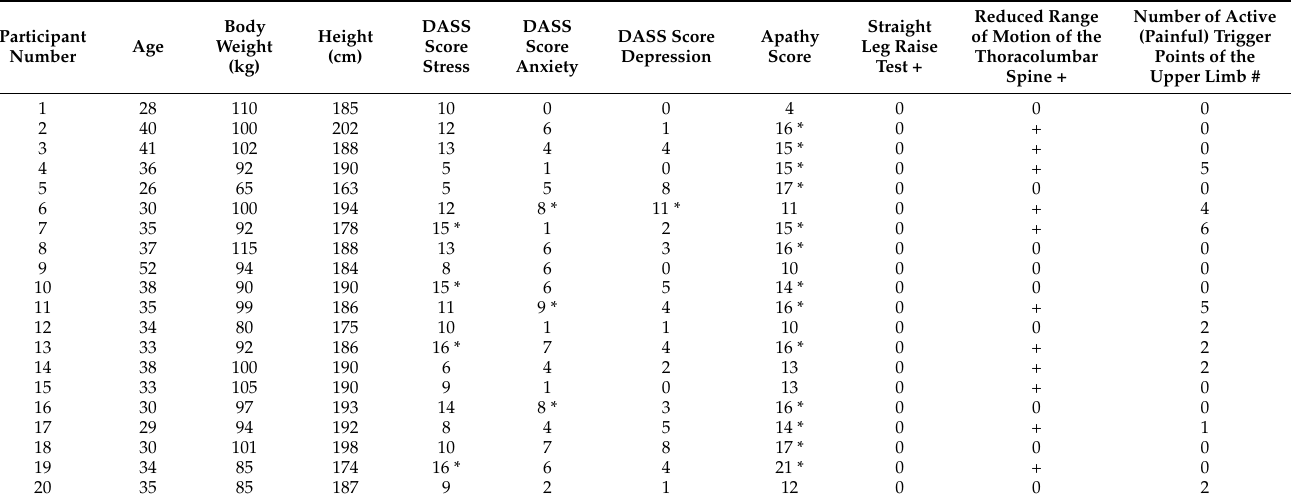
Table 1. Characteristics of the